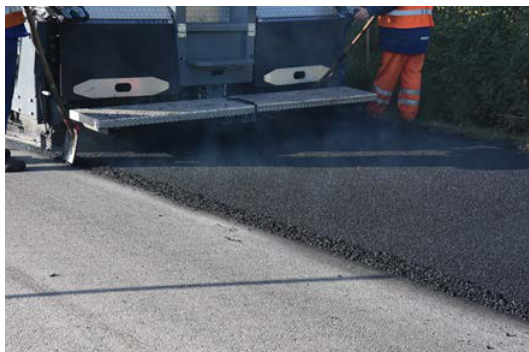
Figure 18. Laying of the poroelastic mixture.